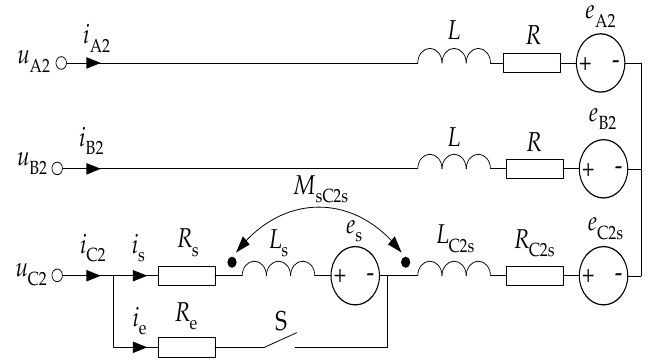
Figure 8. The equivalent circuit diagram of the second set of windings.